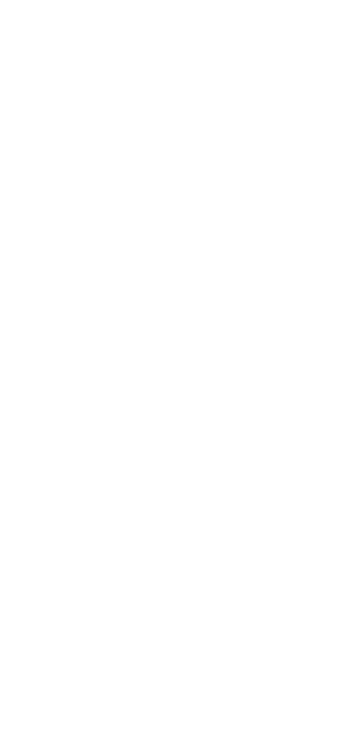
Fig 4. Cumulative verified enrollment in HIV care, by region of facility. Log-rank test for differences in functions = 0.73; P = 0.87.